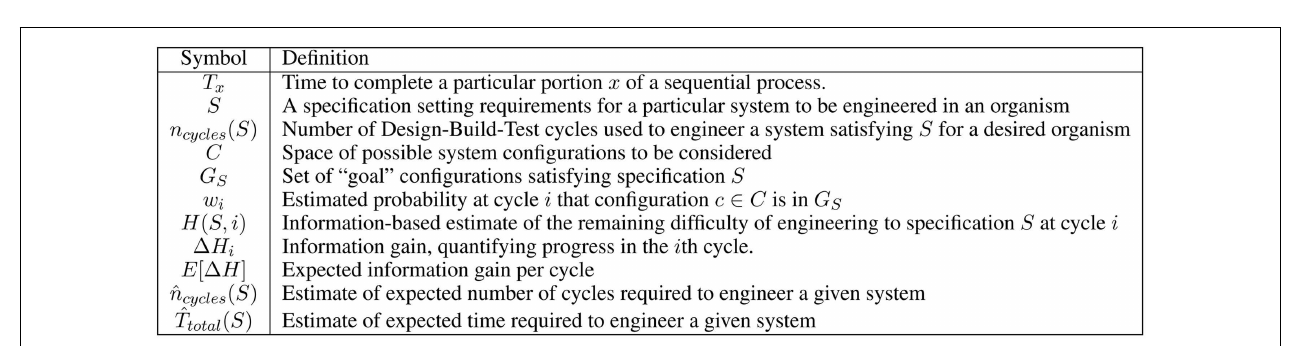
FIGURE 2 |Table of significant notation used for analysis of organism engineering bottlenecks